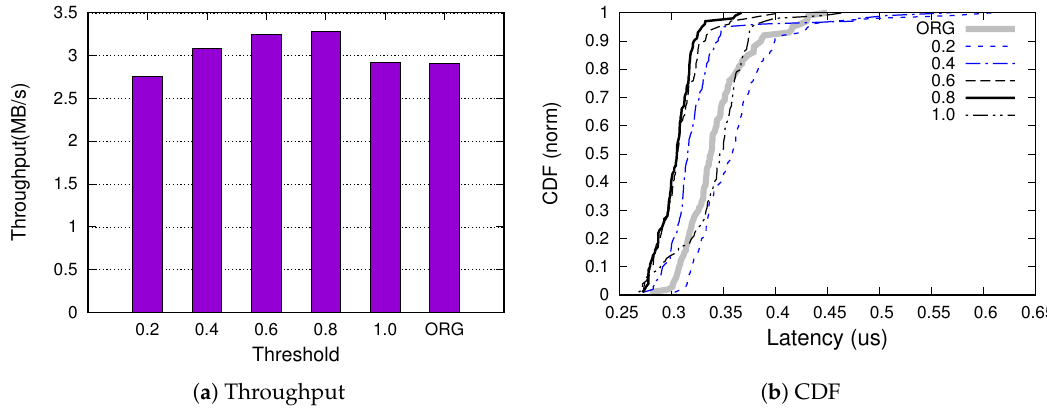
Figure 9. SQLite Performance varying the threshold